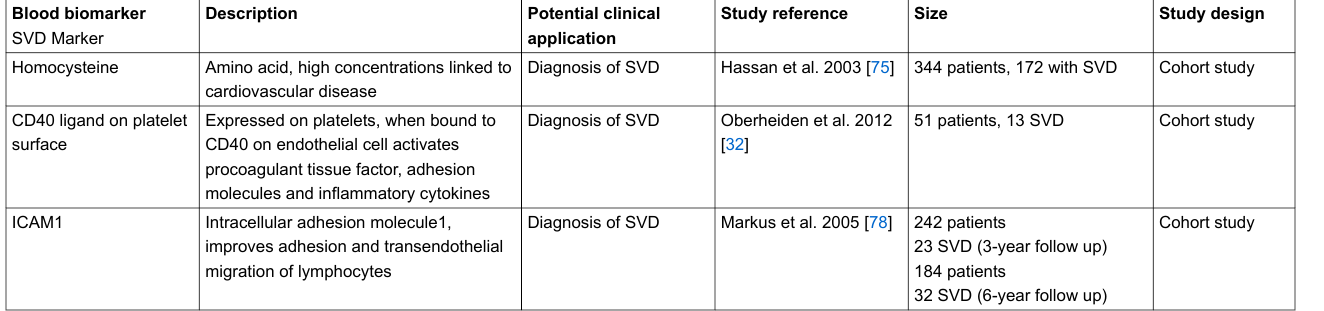
Table 5: Aetiological blood biomarkers of small vessel disease (SVD) stroke. Blood biomarker SVD